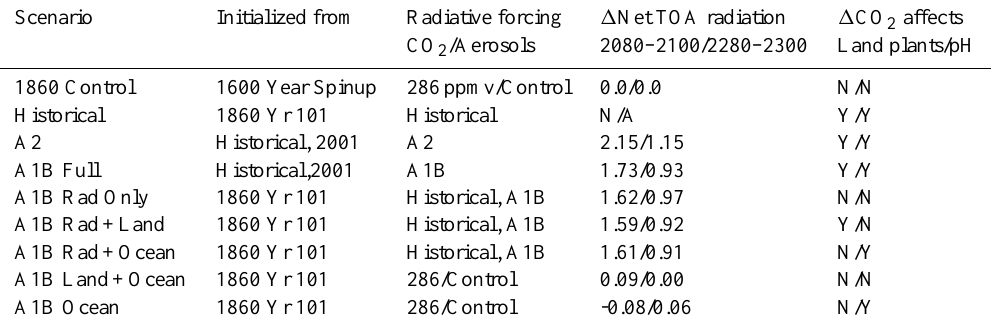
Table 1. Summary of the nine ESM2.1 runs used in this